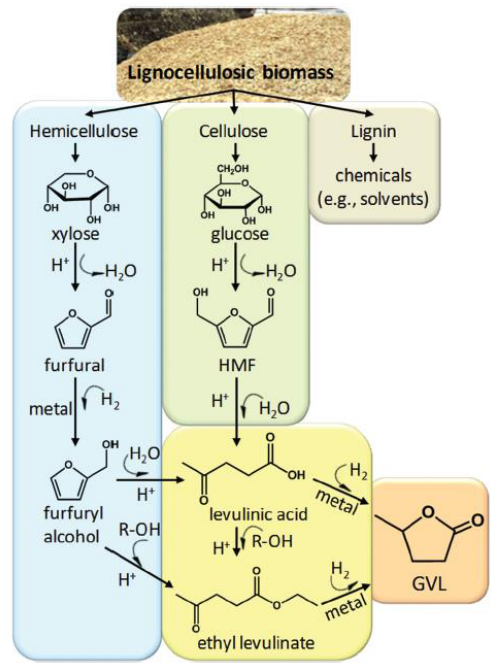
Figure 7. Lignocellulosic biomass and reaction pathways to produce GVL. Reprinted with permission from [98]. Copyright 2013 Royal Society of Chemistry.